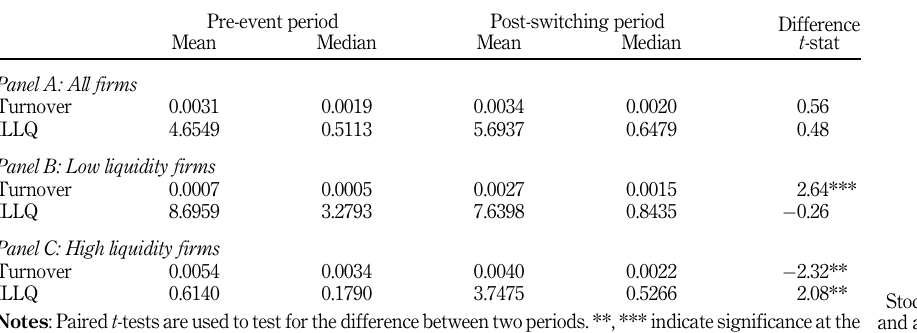
Table V. Stock liquidity before and after the switch to the Main